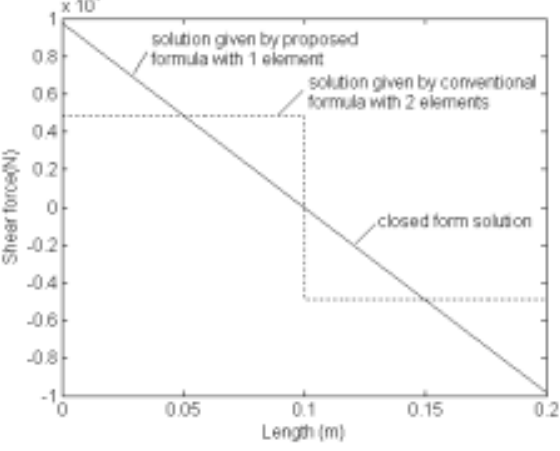
Fig. 7. Shear force diagrams in a simply supported beam under uniformly distributed load.